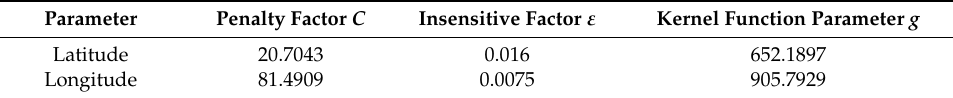
Table 3. Parameter optimization results of the ACDE algorithm.